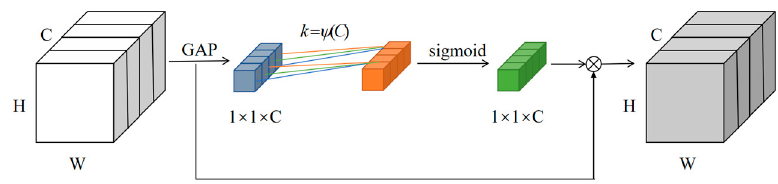
Figure 6. Structure of the ECA module.